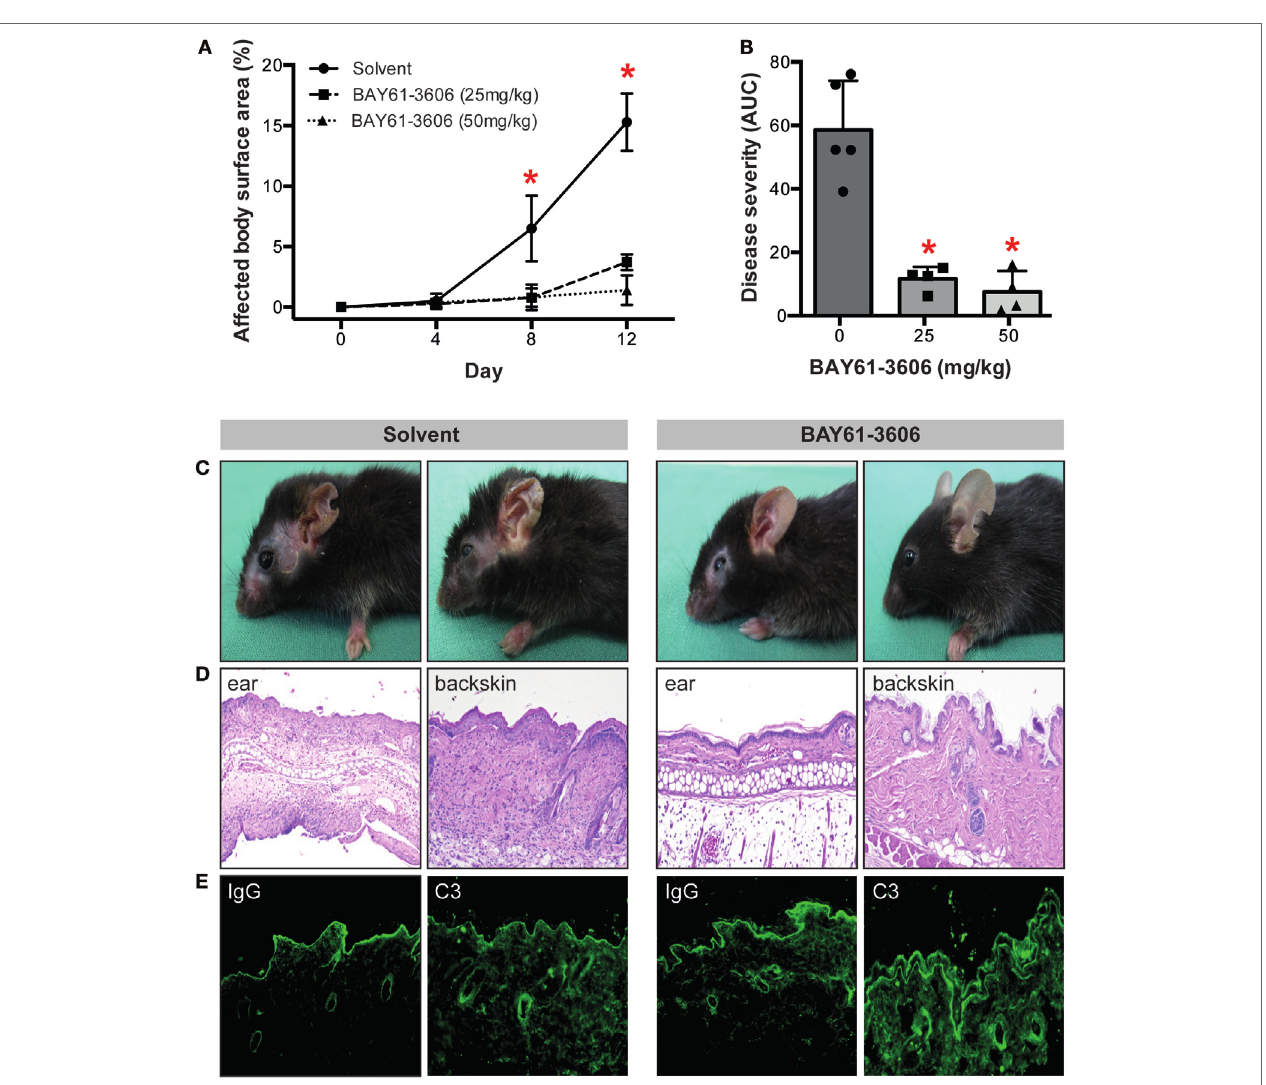
FigUre 2 | The SYK inhibitor BAY61-3606 protects mice from inflammation in antibody transfer-induced epidermolysis bullosa acquisita (EBA). (a) Treatment of mice with the SYK inhibitor BAY61-3606 almost completely protected them from induction of experimentally induced EBA by transfer of anti-type VII collagen IgG. Graph shows the mean (SD) body surface area affected by EBA skin lesions. (B) Overall disease activity was calculated as area under the curve (AUC) derived from individual mice in each of the treatment groups. Here, the mean (SD) of the AUC is shown. Individual dots represent disease severity (AUC) of individual mice (* p < 0.05, ANOVA with a Bonferroni post-test, n = 4–5 mice/group). Representative (c) clinical images of mice at day 12 of the experiment, (D) H&E-stained skin sections at 100 × original magnification and (e) direct immunofluorescent microscopy staining for IgG and C3 from perilesional skin from solvent (left)- and BAY61-3606 (right)-treated animals (50 mg/kg dose) at 100 × original magnification. For panels (c,D) , data are based on five solvent and four (per concentration) BAY61-3606 treated